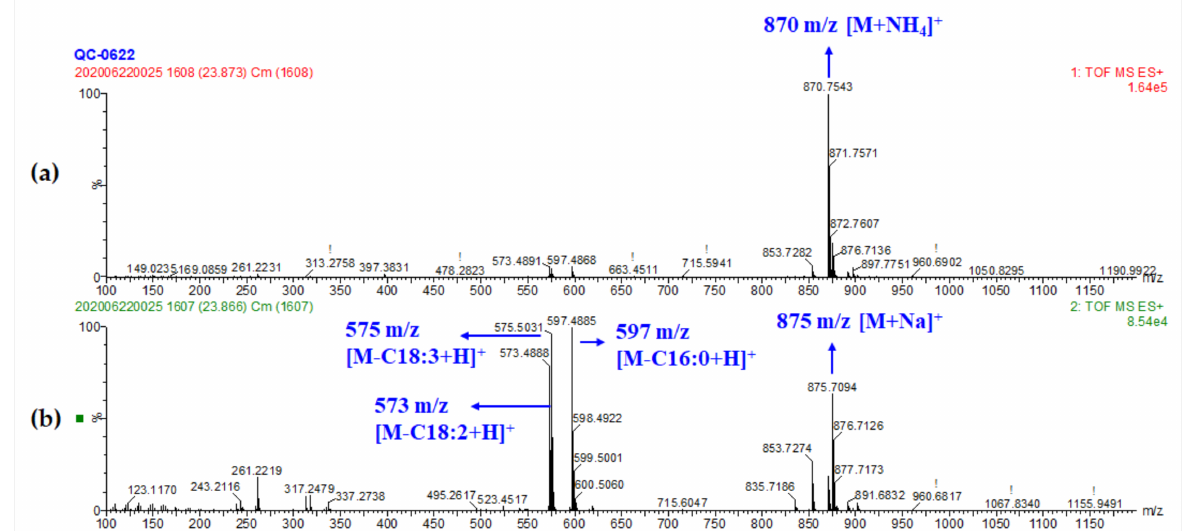
Figure 5. MS spectra of TG (18:3/18:2/16:0). (Peak 48) ( a ) MS 1 spectrum and ( b ) MS 2